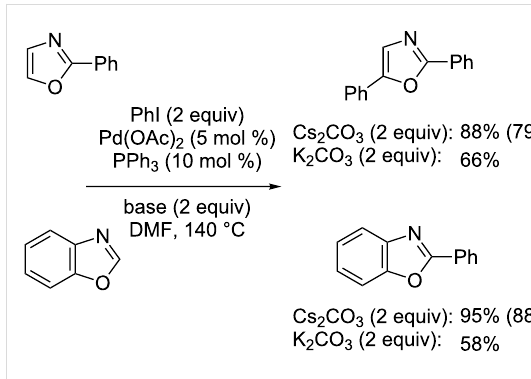
potential inhibitors of vascular endothelial growth